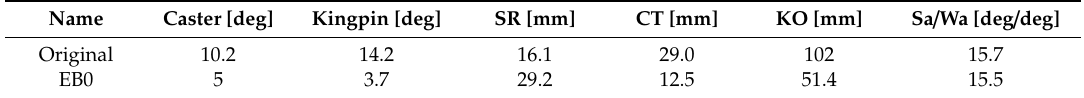
Table 1. EB0 suspension compared with the original one.